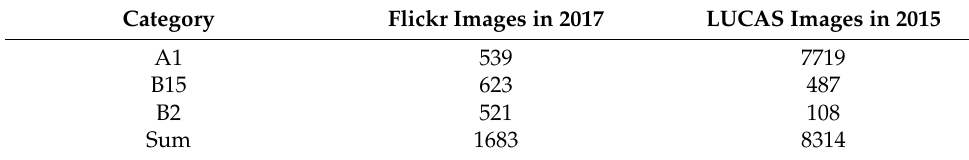
Table 6. Classification results of the natural scene image datasets in the